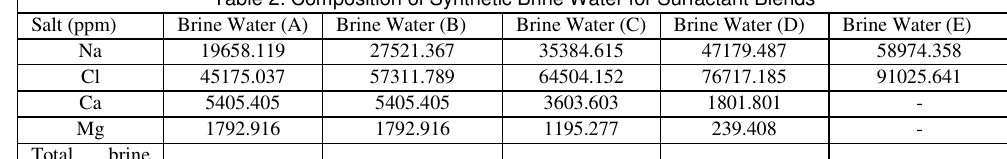
Table 2: Composition of Synthetic Brine Water for Surfactant